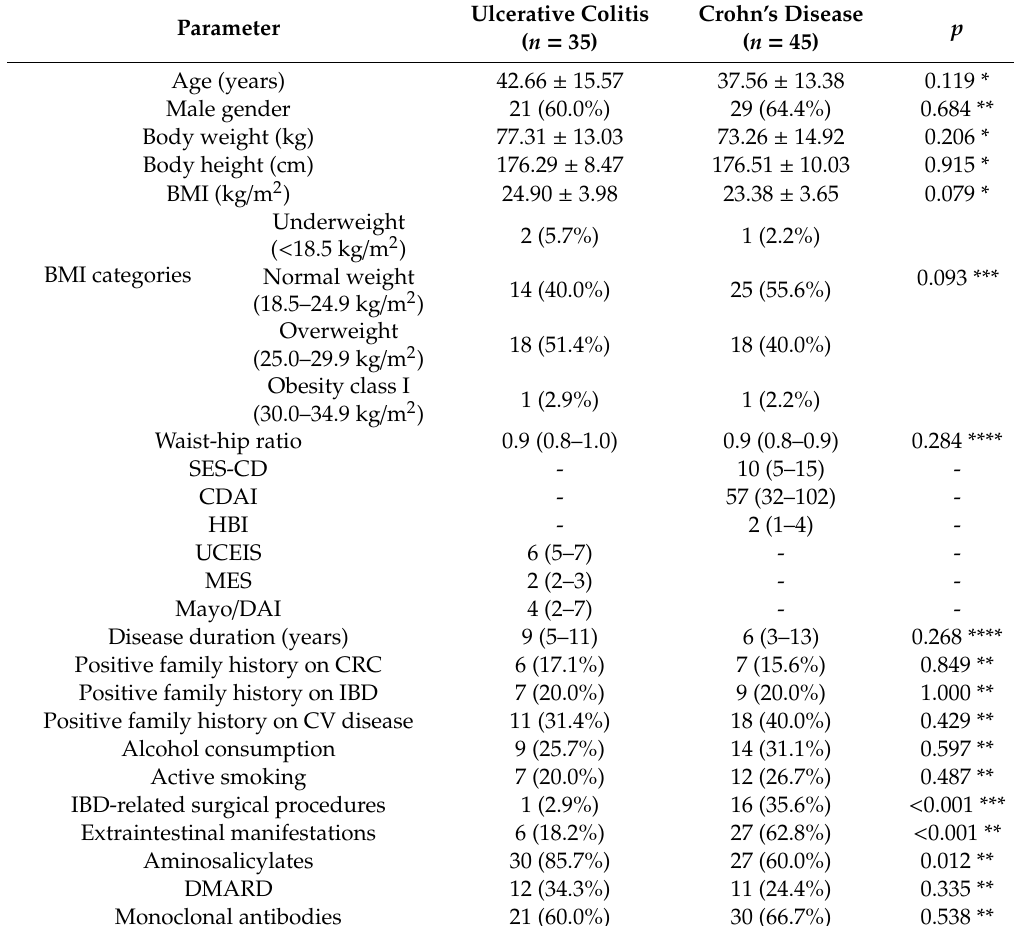
Table 2. Basic anthropometric and disease characteristics of UC and CD